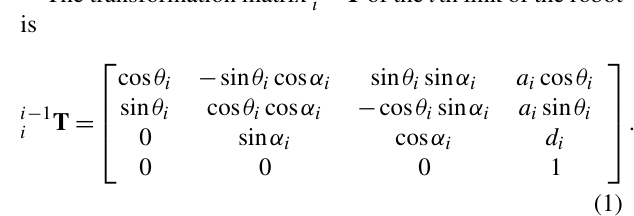
T of the i th link of the i